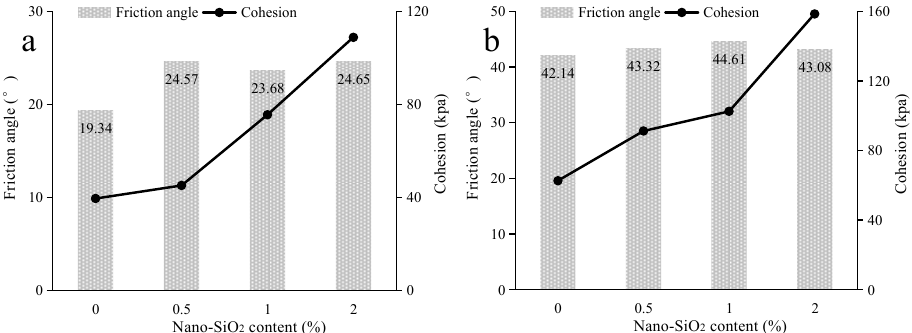
Figure 8. The shear strength parameters of nano-SiO 2 -reinforced clayey soil ( a ) under uncured conditions ( b ) under the cured conditions.